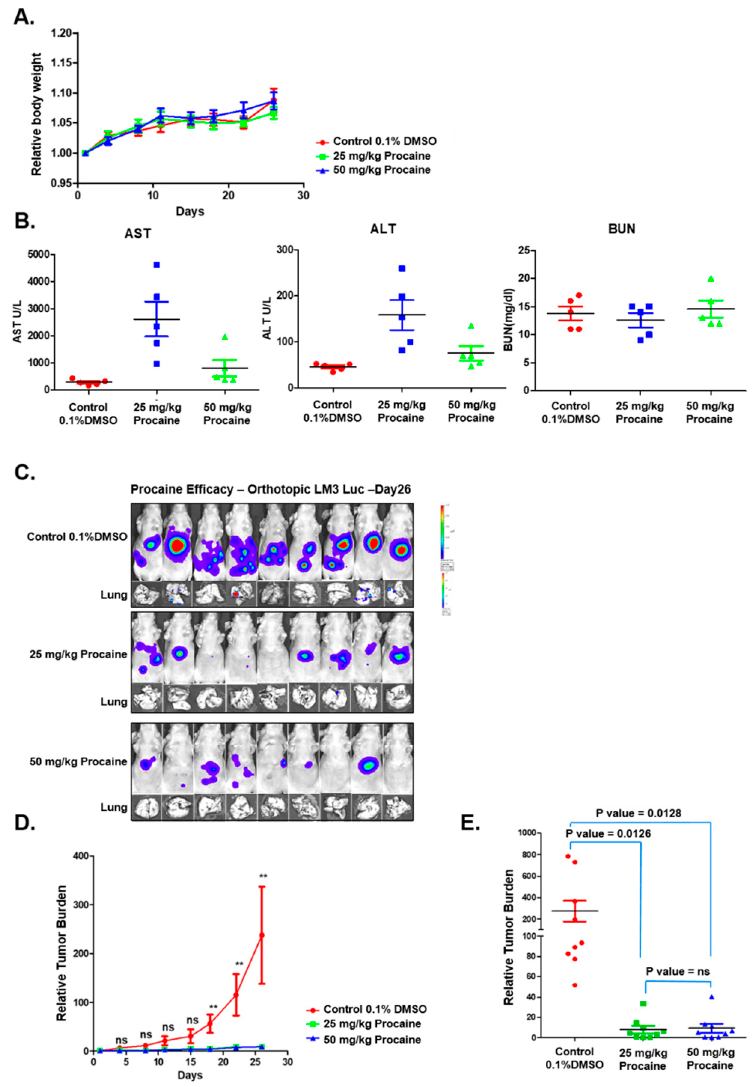
Figure 4. Effect of procaine on tumor growth. ( A ) The graph represents the body weight of mice throughout the acute toxicity study. ( B ) Levels of ALT and AST to analyze the liver function and BUN to determine the kidney function were measured in the serum of experimental animals. ( C ) HCCLM3- Luc cells-derived tumor tissues are orthotopically placed into the liver with a subsequent intraperi- toneal administration of 0.1% DMSO or procaine (25 or 50 mg/kg) twice a week for four weeks. Lungs were examined for metastasis. Tumor growth and metastasis were monitored using bioluminescence imaging. ( D ) Tumor burden was measured in vehicle-treated or procaine-treated tumor-bearing mice. (** p < 0.01) ( E ) The scattered plot indicates tumor burden, which was measured in the different animals in control and at the different doses of